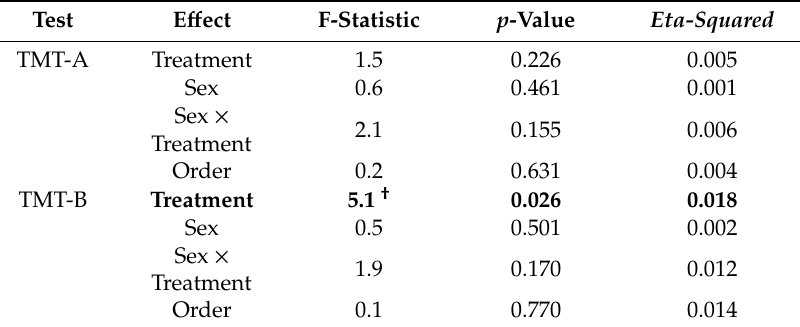
Table 3. Analysis of Variance table for TMT-A and TMT-B test